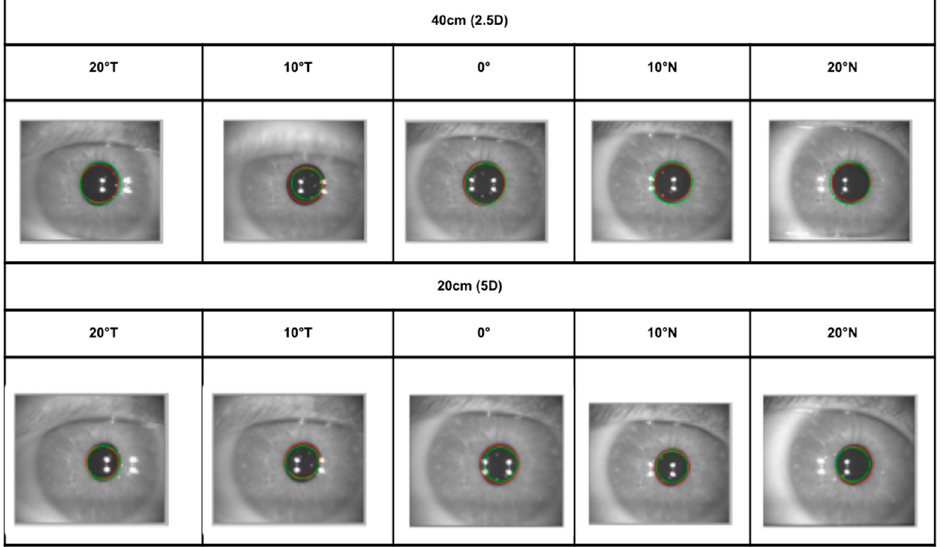
Figure 4. Aberrometer alignment screen captures at each gaze position for 2.5 D ( top ) and 5 D ( bottom ) of accommodative demand.